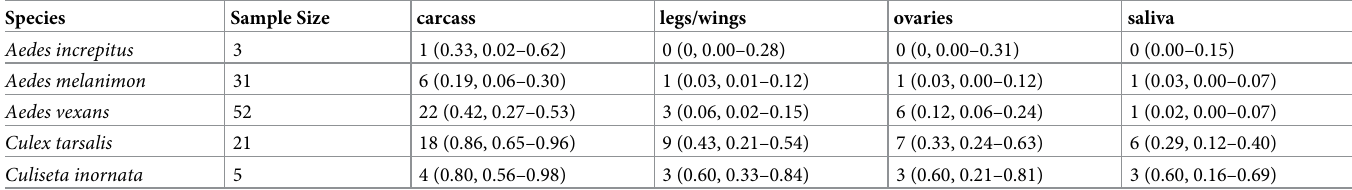
Table 3. Sample sizes and positive samples by species and tissue type. Numbers of positive sampled are expresses as a total number, followed by (proportion positive, 95% CI range). Range of 95% CI are given from estimates of p1, p3, p2, p4 for carcasses, legs/wings, ovaries, and saliva, respectively.